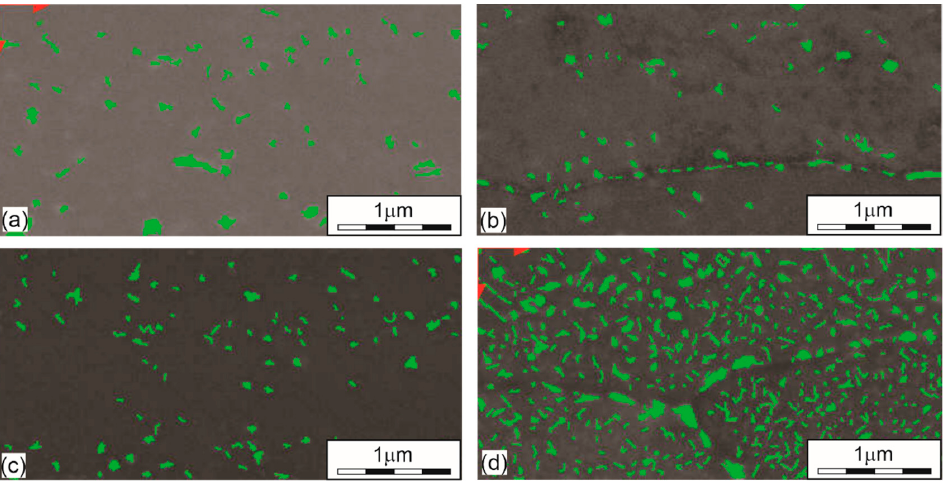
Figure 5. The amount of precipitated phases under different heat treatment conditions. ( a ) QS (3.63%); ( b ) T145 (2.93%); ( c ) T170 (3.05%); ( d ) T195 (15.16%)